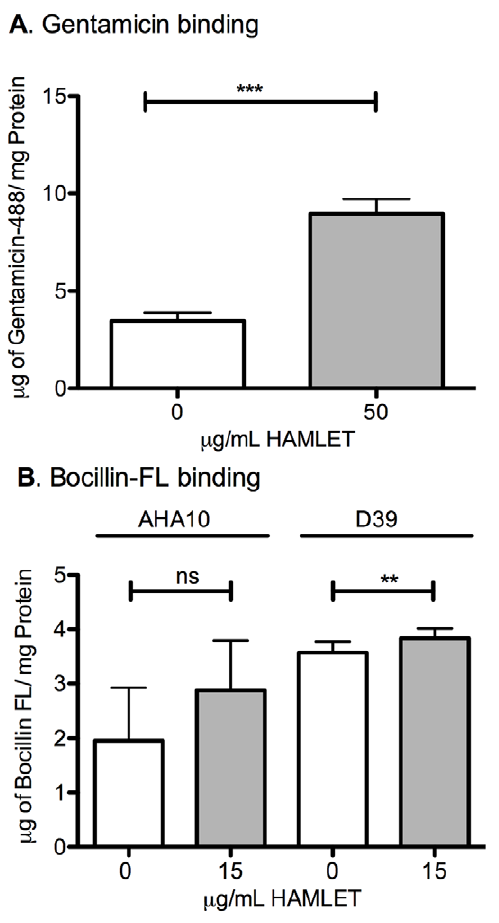
Figure 5. Impact of HAMLET on uptake and binding of gentamicin and Bocillin FL. (A) S. pneumoniae D39 were incubated with Alexa Fluor 488-gentamicin in the presence or absence of HAMLET. HAMLET significantly increased the cell-associated level of gentamicin. (B) The penicillin-resistant strain SP670 and the penicillin-sensitive strain D39 were incubated with the fluorescent beta-lactam Bocillin FL in the presence or absence of HAMLET. HAMLET did not increase the cell- associated level of Bocillin FL in either strain. The results are based on three individual experiments with duplicate samples. Statistics was performed using the unpaired Student t-test. Significance was indicated as follows: **=P , 0.01, ***=P , 0.001, ns = not significant.